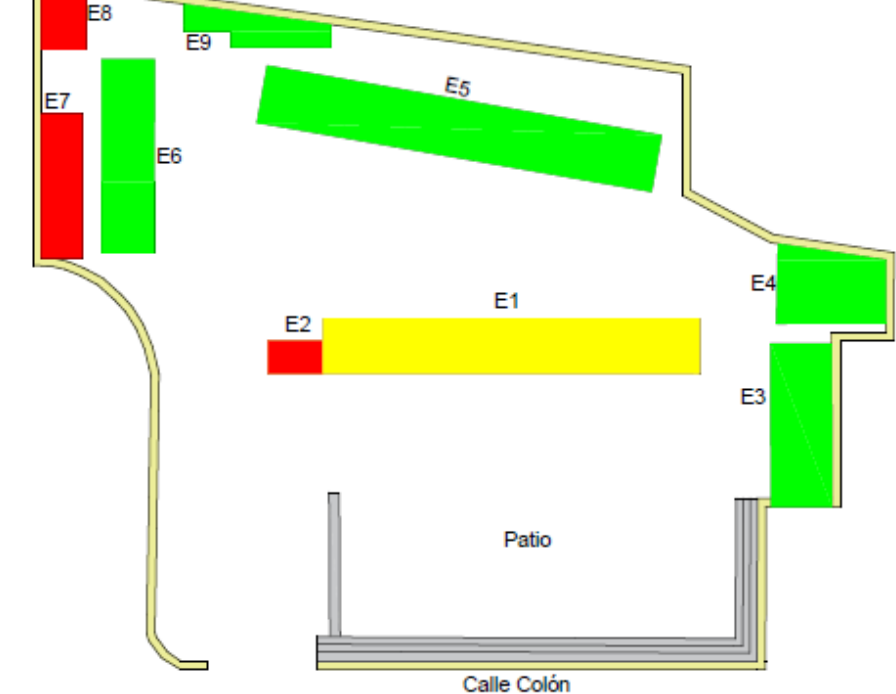
Figure 5. Location of vulnerable buildings in the “Santa Ana” Private School. This figure indicates the buildings located as vulnerable after the evaluation, where green—low vulnerability, yellow—medium vulnerability, red—high vulnerability. Table 12. Summary of building evaluation and total vulnerability of the school. Edif.